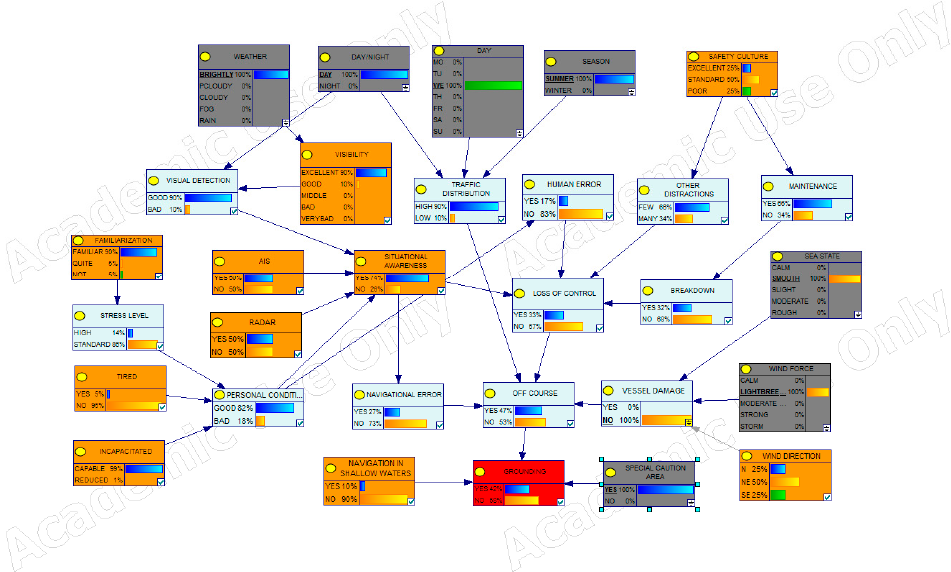
Figure 10. Model of the grounding of a small passenger ship “Cicero” according to the report on the maritime accident.